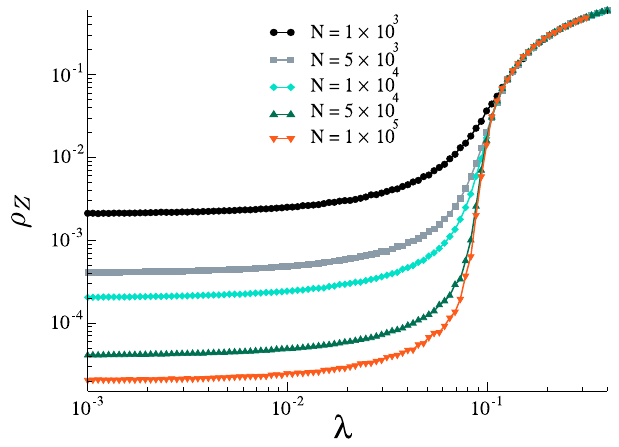
Fig. 2 Phase diagram for the standard MT model. Results for α = 1 and different sizes on a random regular networks with 〈 k 〉 k = 10.